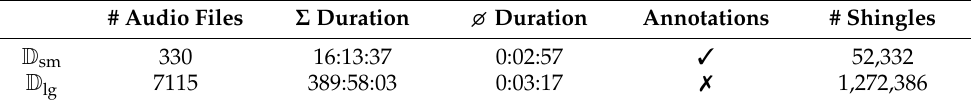
Table 1. Statistics for the used datasets. Duration format hh:mm:ss. Annotations refer to the availability of complete annotations for the musical pieces underlying the recordings (required to evaluate retrieval quality). Σ refers to the total, and refers to the (cid:31)